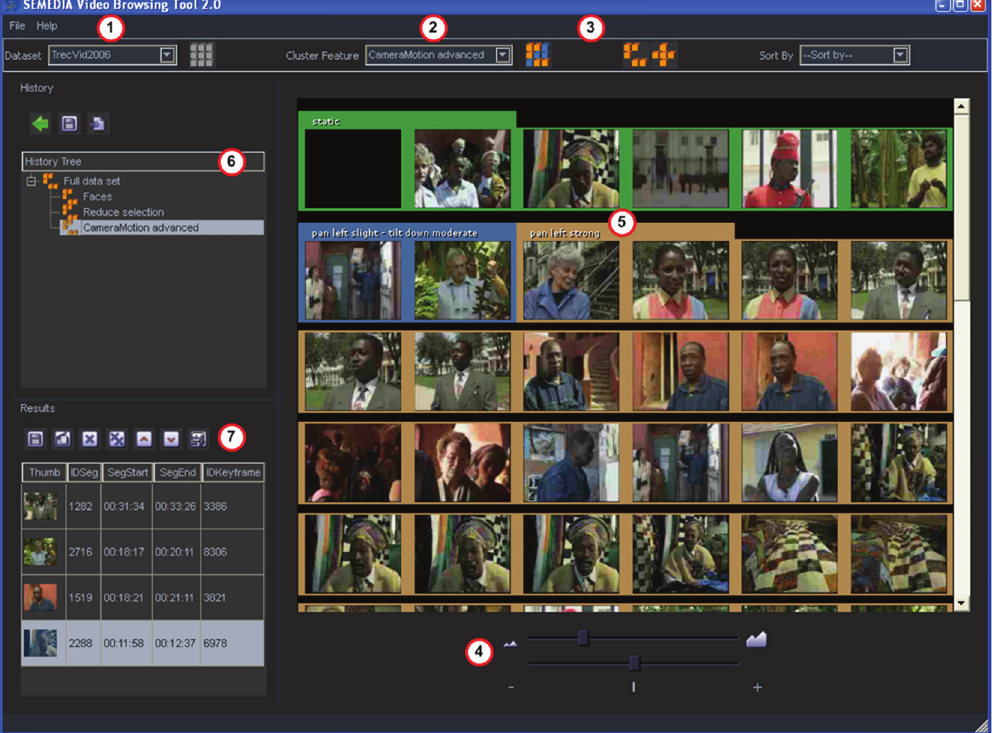
Figure 4: Screenshot of the video browsing tool desktop application.